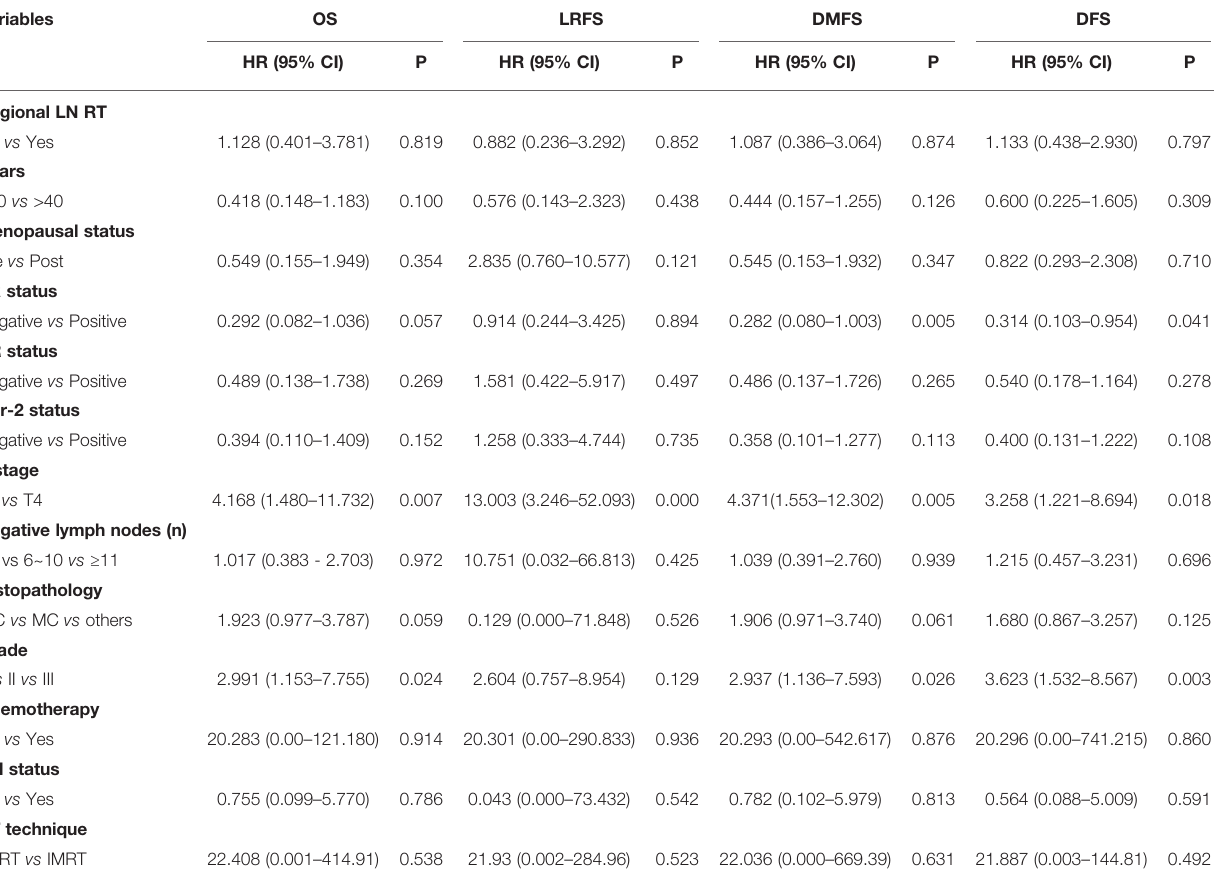
TABLE 2 | Univariate Cox regression analysis of prognostic